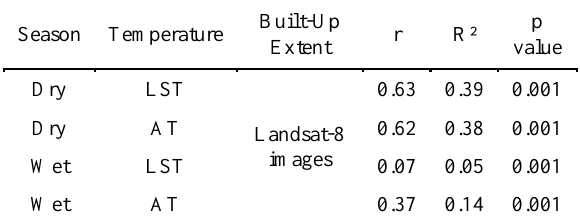
Table 8. Correlation between temperature and built-up extent